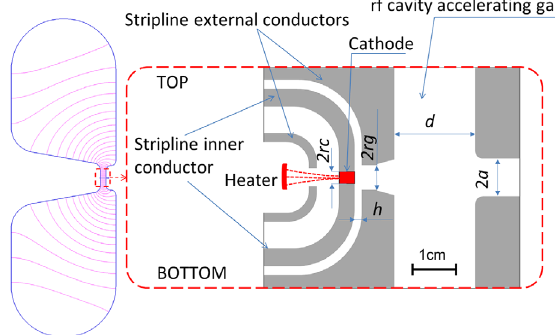
FIG. 1. A schematic of the proposed HV pulse-gated therm- ionic rf gun. The inset shows the cathode assembly and the on-axis region of an accelerating gun cavity. A cylindrical single- crystal CeB 6 cathode of radius r , schematically shown by the red c rectangle, is installed into the central conductor of a stripline- loop. The wall of the gun cavity embodies the outer conductor of the stripline-loop so that electron bunches are injected to the gun cavity through an aperture in this part of the outer conductor. The input aperture radius is r and the radius of the output cavity g aperture is a . The accelerating gaps of the stripline-loop and cavity are h and d , respectively. The cathode can be heated by a DC laser or a diode DC electron gun labeled as the heater in the inset. The dotted red lines represent schematically the rays from the laser heater or the trajectories of electrons emitted by the electron